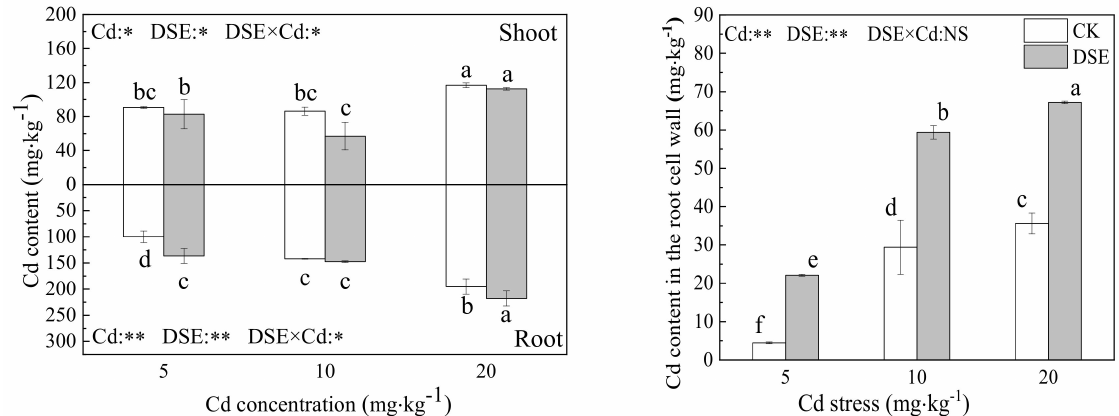
Figure 2. Effects of DSE inoculation on Cd concentration and Cd content of maize shoot, root, and cell wall under Cd stress. Error bar indicates standard deviation. Cd: cadmium treatment; CK: the control of non-inoculation; DSE: Exophiala pisciphila inoculation; different little letters refer to p < 0.05 according to LSD test. “NS”, “*”, and “**” mean no significance, p < 0.05 and p < 0.01 according to two-way ANOVA, respectively.